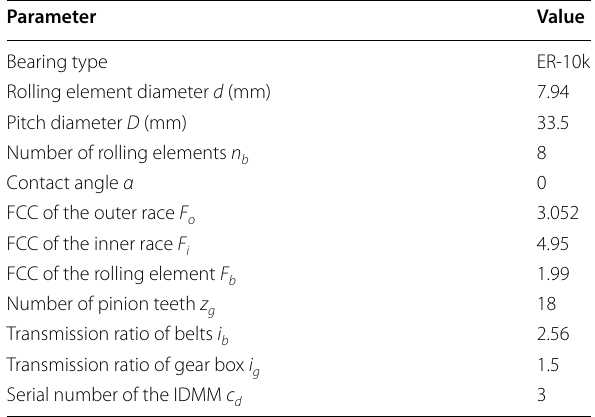
Table 2 Parameters of bearing and